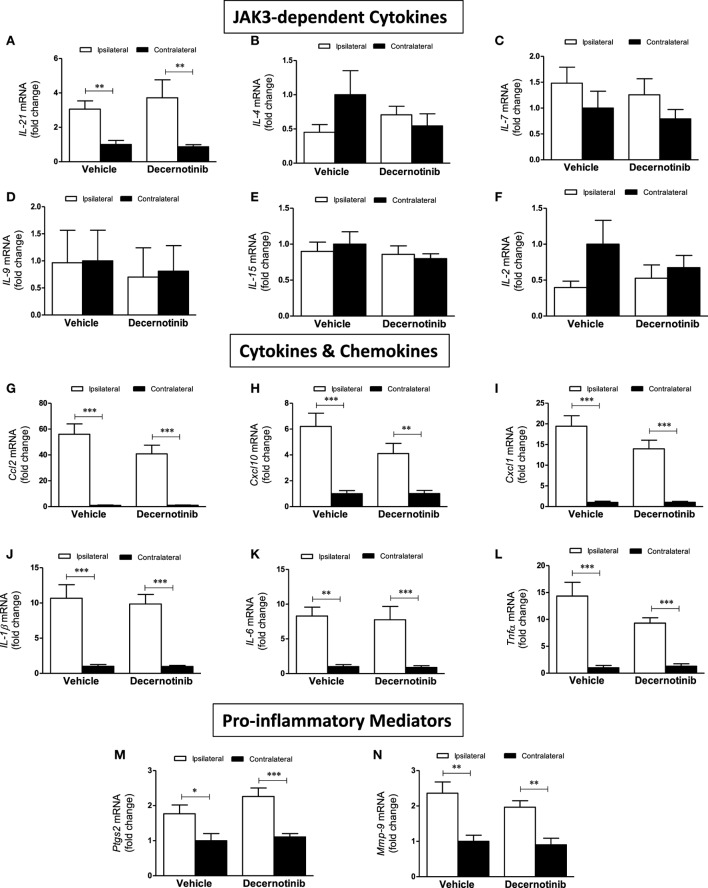
(A)
IL-21 is increased in the ipsilateral cortex compared to the contralateral cortex (**P < 0.01) (B)
IL-4 does not appreciably change between treatment groups or hemisphere. (C) There is a trend toward increased IL-7 in the ipsilateral cortex. (D) There is no change in IL-9 between groups. (E) There is no change in IL-15 between groups. (F) There is no significant change in IL-2 across groups. (G)
Ccl2 is significantly increased in the ipsilateral cortex in vehicle- and 10 mg/kg decernotinib-treated groups (***P < 0.01). (H)
Cxcl10 is significantly increased in the ipsilateral cortex in both groups (***P < 0.01; **P < 0.01). (I)
Cxcl1 is increased in the ipsilateral cortex in vehicle- and 10 mg/kg decernotinib-treated groups (***P < 0.01). (J)
IL-1β is increased in the ipsilateral cortex in vehicle- and 10 mg/kg decernotinib-treated groups (***P < 0.01). (K)
IL-6 is increased in the ipsilateral cortex in vehicle- and 10 mg/kg decernotinib-treated groups (**P < 0.01; ***P < 0.01). (L)
Tnfα is increased in the ipsilateral cortex in vehicle- and 10 mg/kg decernotinib-treated groups (***P < 0.01). (M)
Ptgs2 is increased in the ipsilateral cortex in vehicle- and 10 mg/kg decernotinib-treated groups (*P < 0.05; ***P < 0.01). (N)
Mmp-9 is increased in the ipsilateral cortex in vehicle- and 10 mg/kg decernotinib-treated groups (**P < 0.01) Statistical analyses performed with a two-way ANOVA and Bonferroni post-test; vehicle n = 5, 10 mg/kg decernotinib, n = 7.